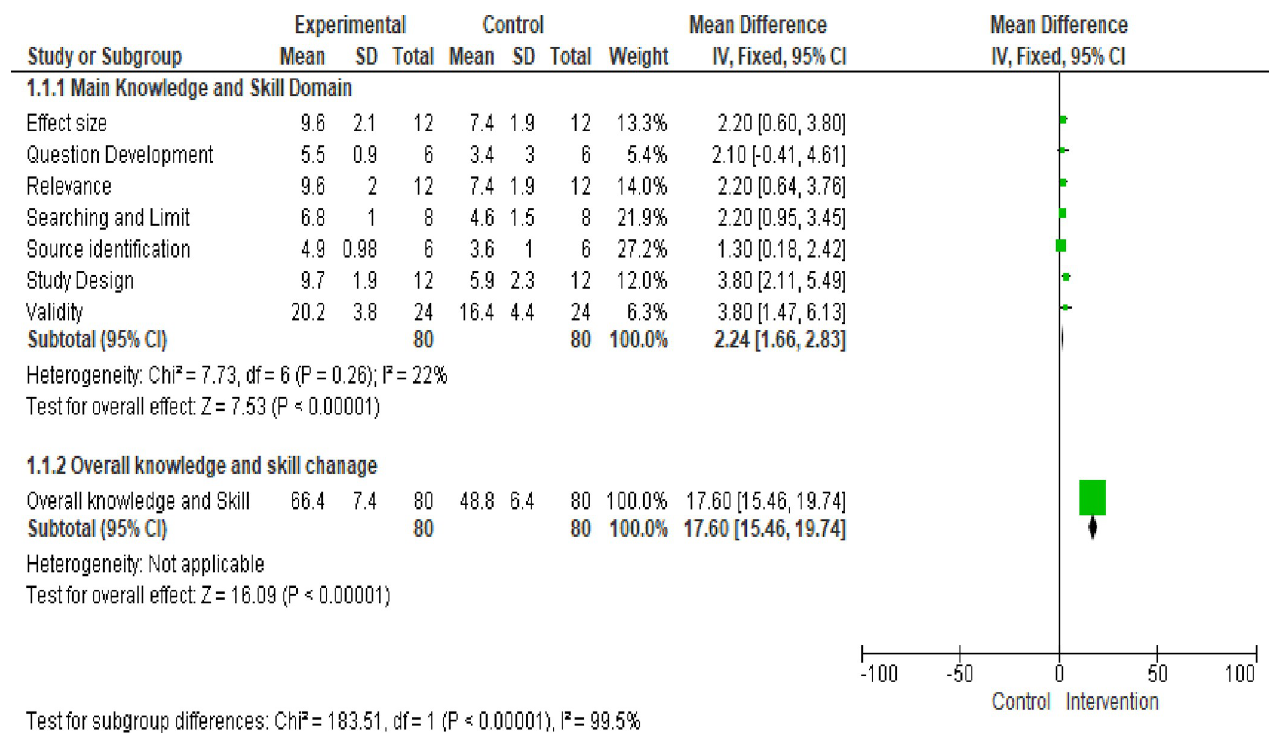
Fig 2. Frost plot of change of main domain of knowledge and skill for post graduate students in Ethiopia 2022.